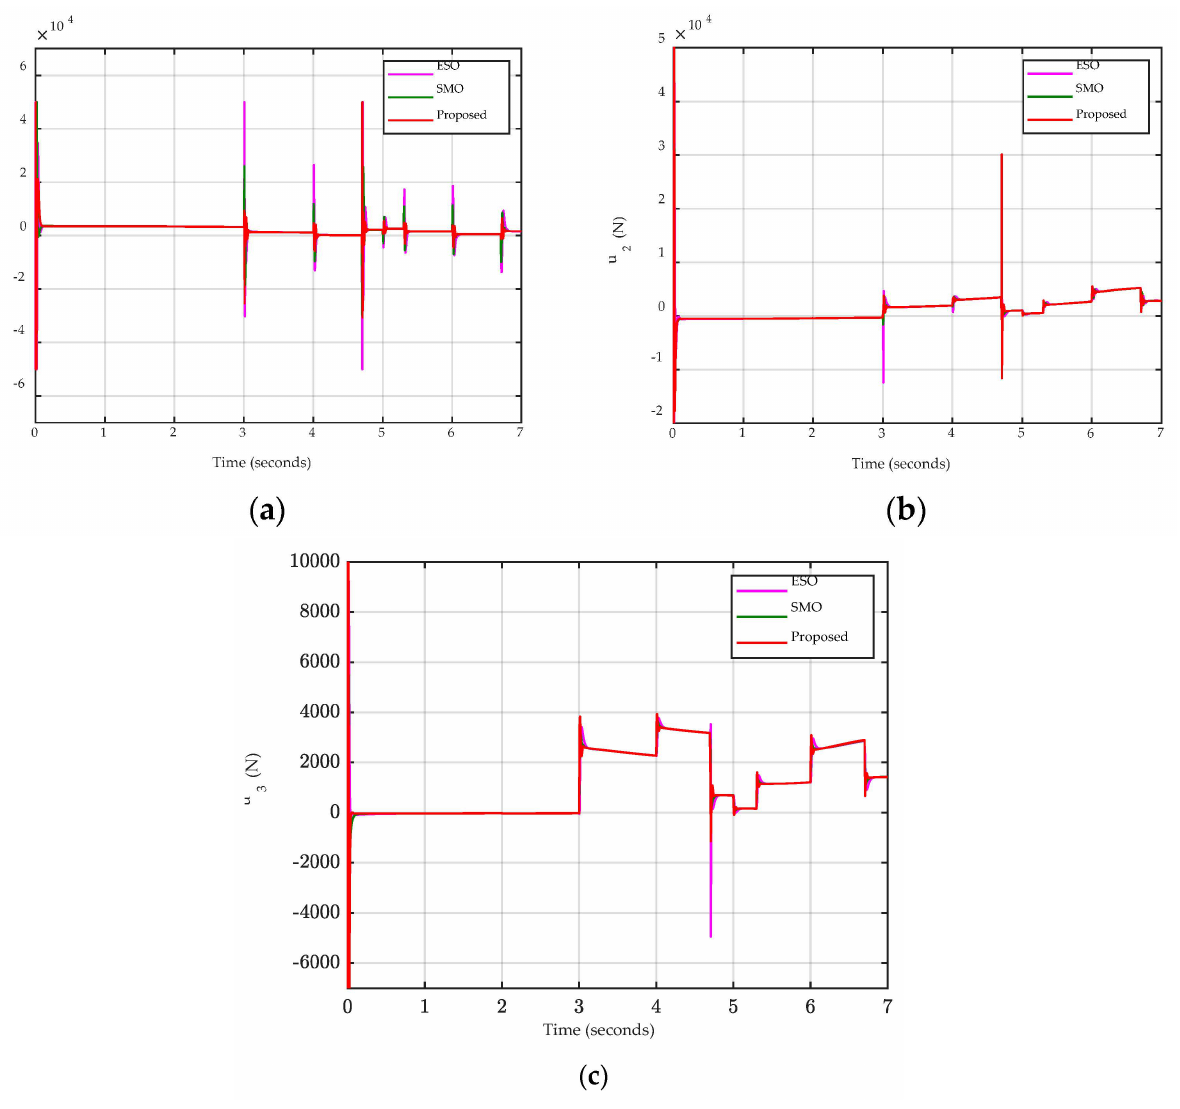
Figure 8. Control signals of ( a ) boom, ( b ) arm, and ( c ) bucket in Case